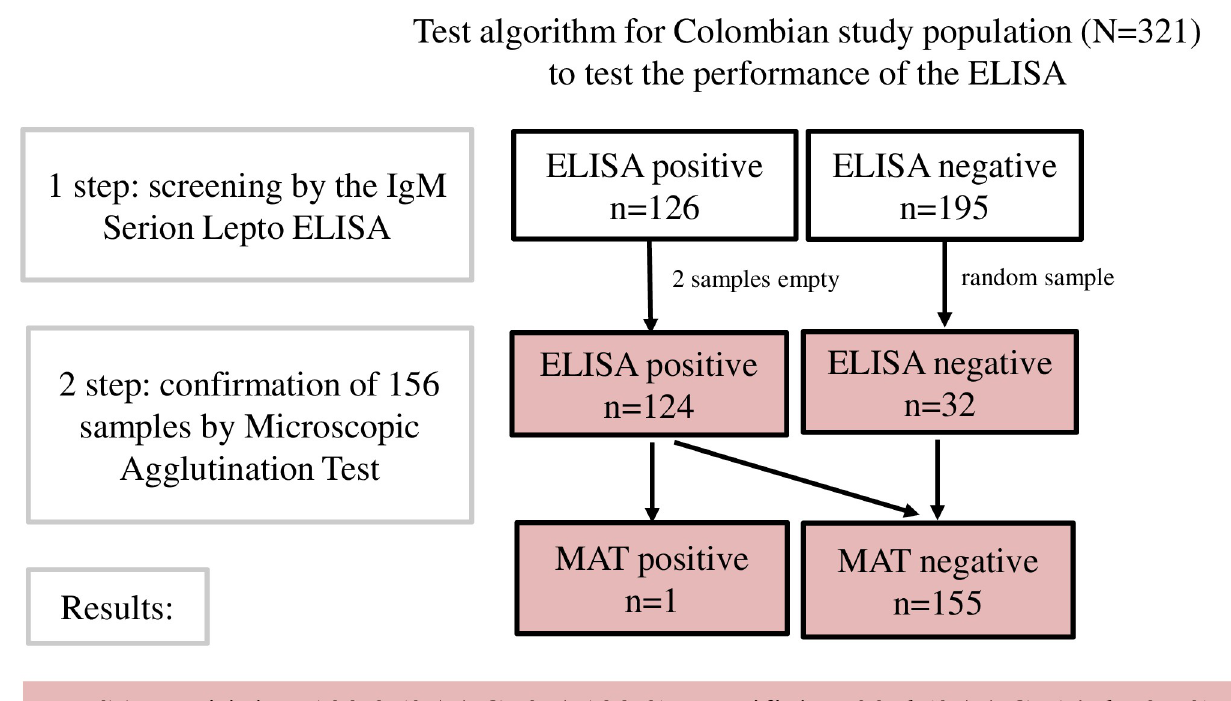
Fig 1. The 321 sera of the Colombian study population were screened by the Serion ELISA classic Leptospira IgM (Institut Virion\Serion GmbH, REF EST125M). All ELISA-positive (n = 124) and a random sample of the ELISA-negative samples (n = 32) were tested for confirmation by the Microscopic Agglutination Test (MAT = imperfect reference test) to assess the performance of the ELISA (in rose). Only one of the ELISA-positive serum samples tested Leptospira seropositive by the MAT, while 123 ELISA positive samples were negative in the MAT. All ELISA negative results, tested by MAT were confirmed by the MAT as